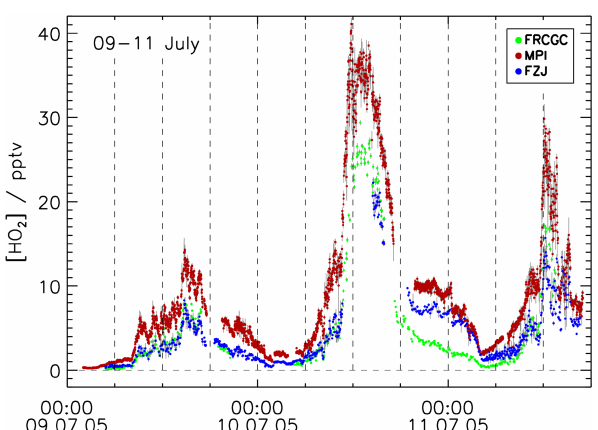
Fig. 6. Time series of HO 2 mixing ratios during ambient air sam- pling. Data were averaged to a 1min time resolution, if the original data set provided a higher time resolution.